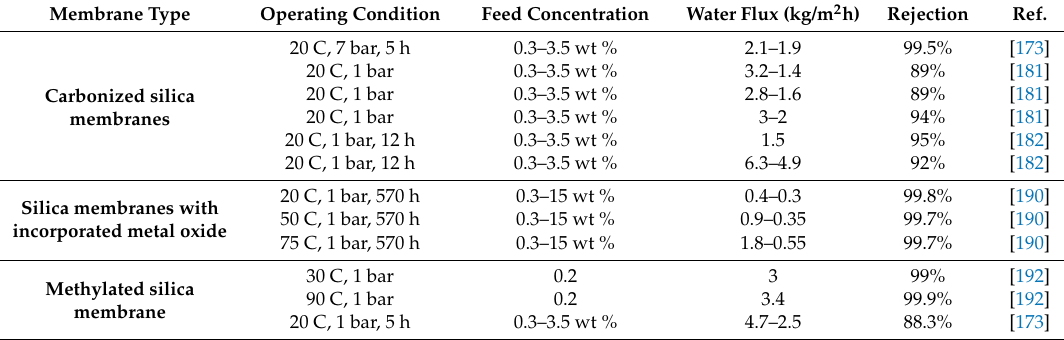
Table 5. Flux and rejection of modified silica membrane in desalination tests with NaCl